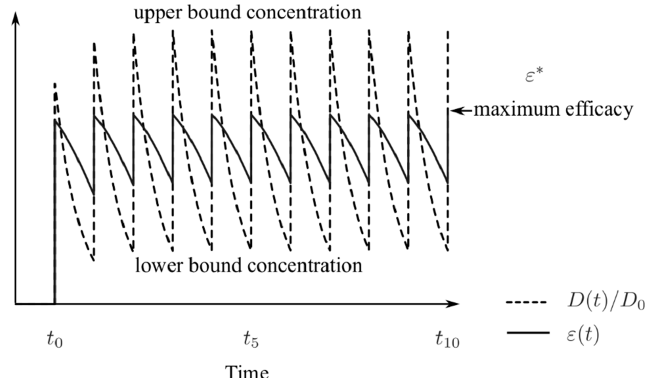
Figure 3. Illustration of the drug dynamics (dashed line) when administered at constant time intervals and at a fixed dose, starting at t 0 ; the solid line is the corresponding drug efficacy. Both the drug concentration and efficacy fluctuate between their bounds between intakes.